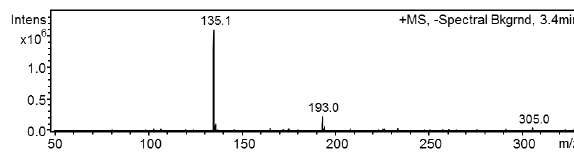
Figure 3. Typical MS of 0.01 M Gly in 3 M AS at 3.4 min retention time. 2 Fig. 3. Typical MS of 0.01 M Gly in 3 M AS at 3.4min retention 3 time.